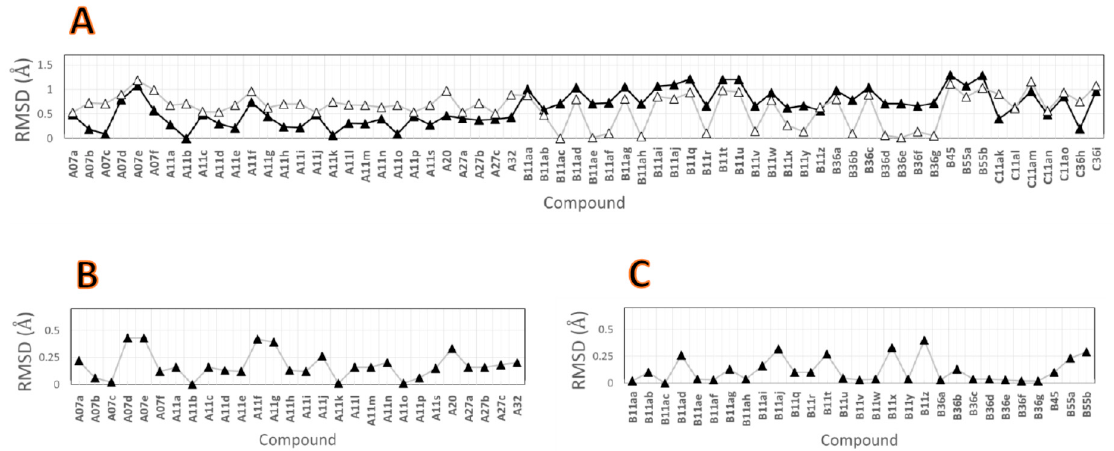
Figure 3. The root mean square deviation (RMSD) values that were used to compare the 3D positions of the neck and head groups of the studied DPDAs. ( A ) RMSD values between the neck groups of compounds relative to the neck groups of A11b (closed triangle) and B11ac (open triangle). ( B ) RMSD values between the head group of compounds from series A relative to the head group of A11b . ( C ) RMSD values between the head group of compounds from series B relative to the head groups of B11ac .